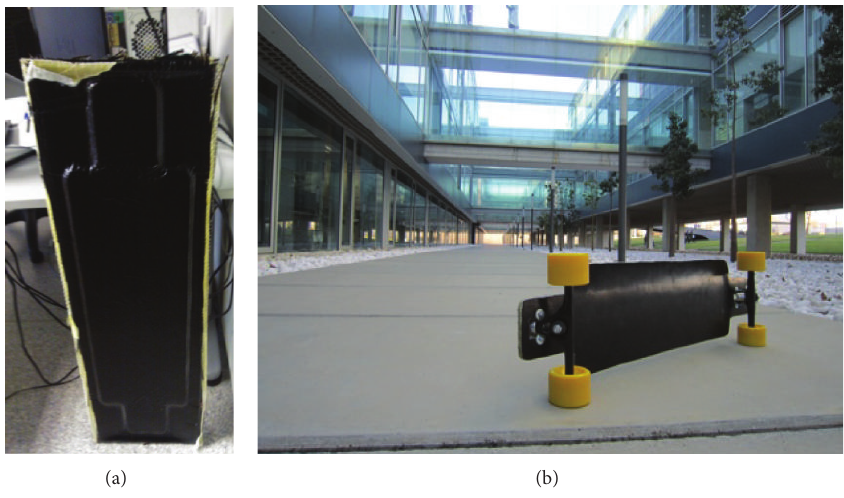
Figure 13: Longboard before demoulding and final obtained part.